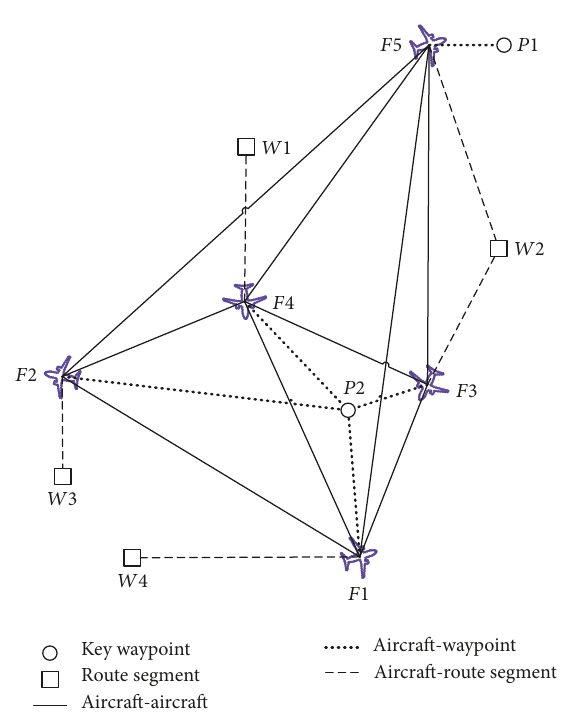
Figure 6: Schematic diagram of air traffic situation complexity